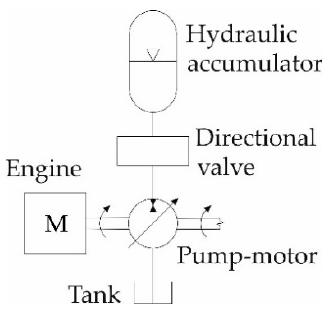
Figure 6. Parallel configuration.